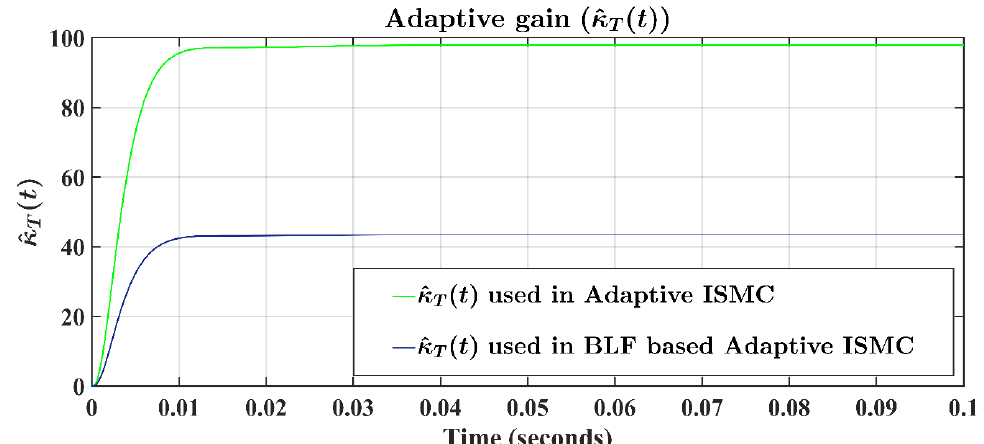
Figure 8. The response of the adaptive gain used in adaptive backstepping ISMC (green) and BLF ‐ based adaptive backstepping ISMC (blue).